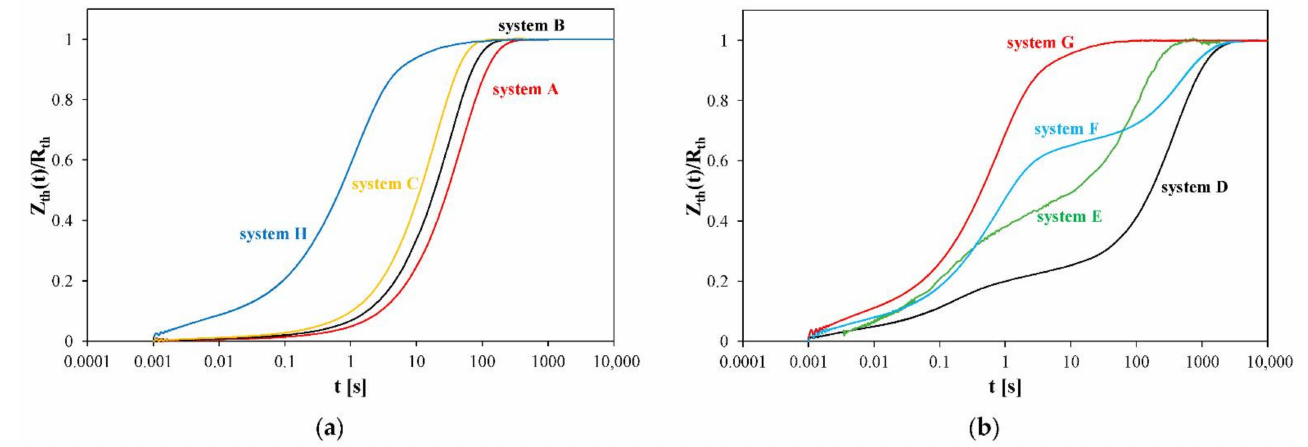
Figure 14. Self-transient thermal impedance waveforms normalised to self-thermal resistance of the investigated MOSFETs for the investigated cooling systems: A, B, C and H ( a ), D, E, F, G ( b ).